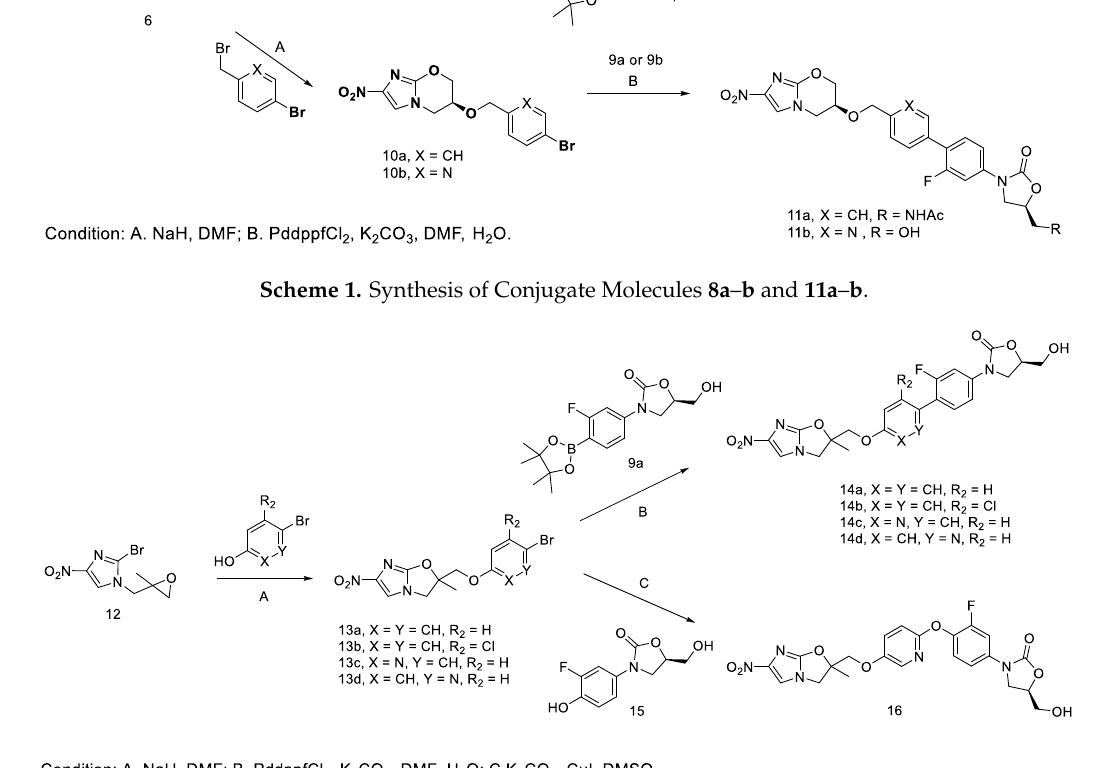
Scheme 2. Synthesis of Conjugate Molecules 14a – d and 16.